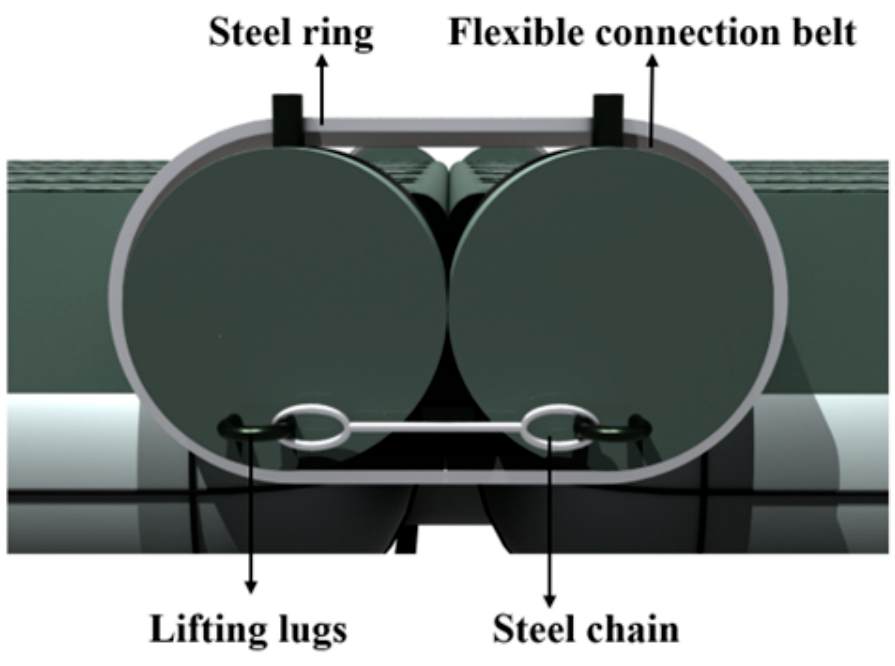
Figure 4. Longitudinal connection of the floating